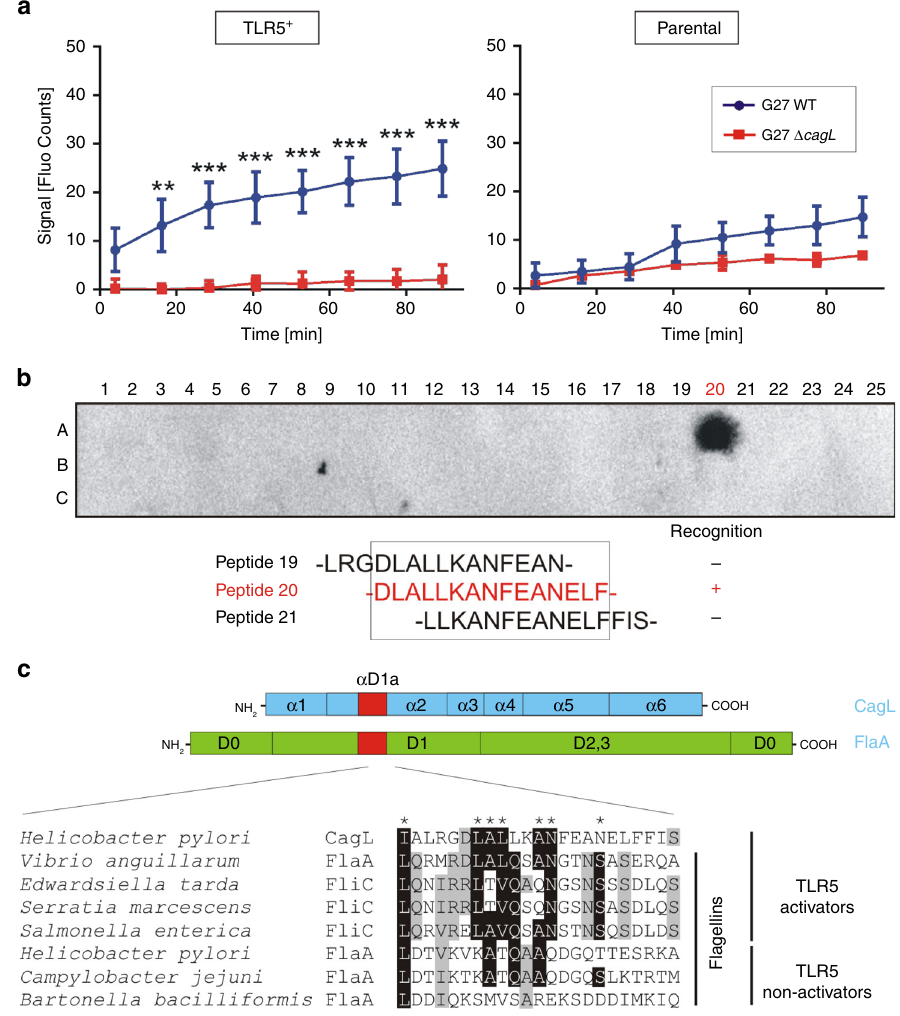
Fig. 2 The T4SS-pilus protein CagL of H. pylori interacts directly with TLR5. a Binding of FITC-labeled H. pylori G27 WT or Δ cagL mutant to parental and TLR5 + cells, as monitored over time using the LigandTracer system under live cell conditions. b Peptide arrays of overlapping CagL 15-mer peptides were incubated with recombinant His-tagged TLR5. Probing with α -His antibodies revealed binding of TLR5 to peptide-20, but not the partially overlapping peptides-19 or − 21. c The peptide-20 sequence of CagL shows homology to the fl agellin α D1a domains of TLR5-activating, but not TLR5-non-activating fl agellins. Quantitative data are shown as means ± SD. ** p < 0.01; *** p < 0.001 (two-way ANOVA). Source data are provided as a Source Data fi